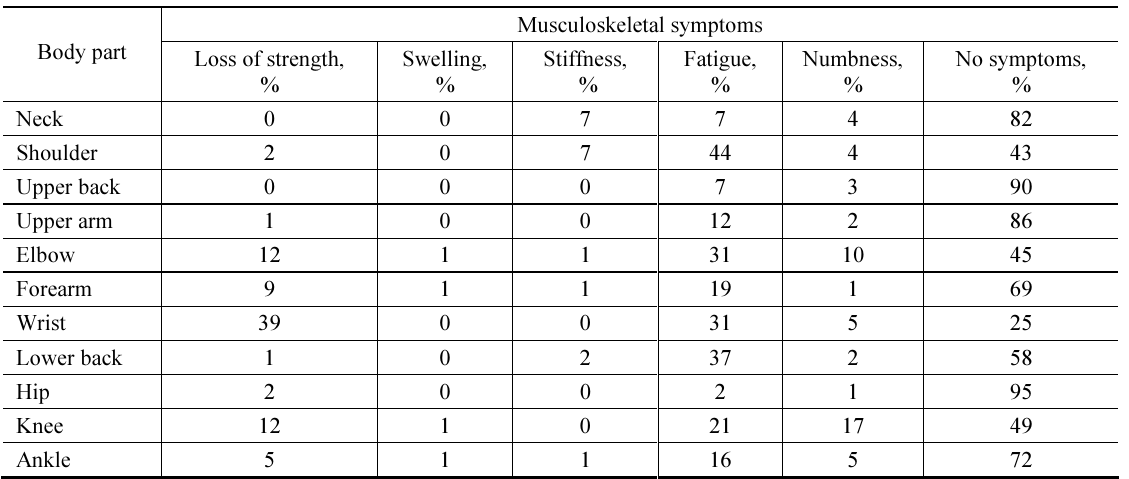
Table 5. Survey of the workers’ work-related musculoskeletal symptoms Body part Loss of strength, Neck 0 0 7 7 4 82